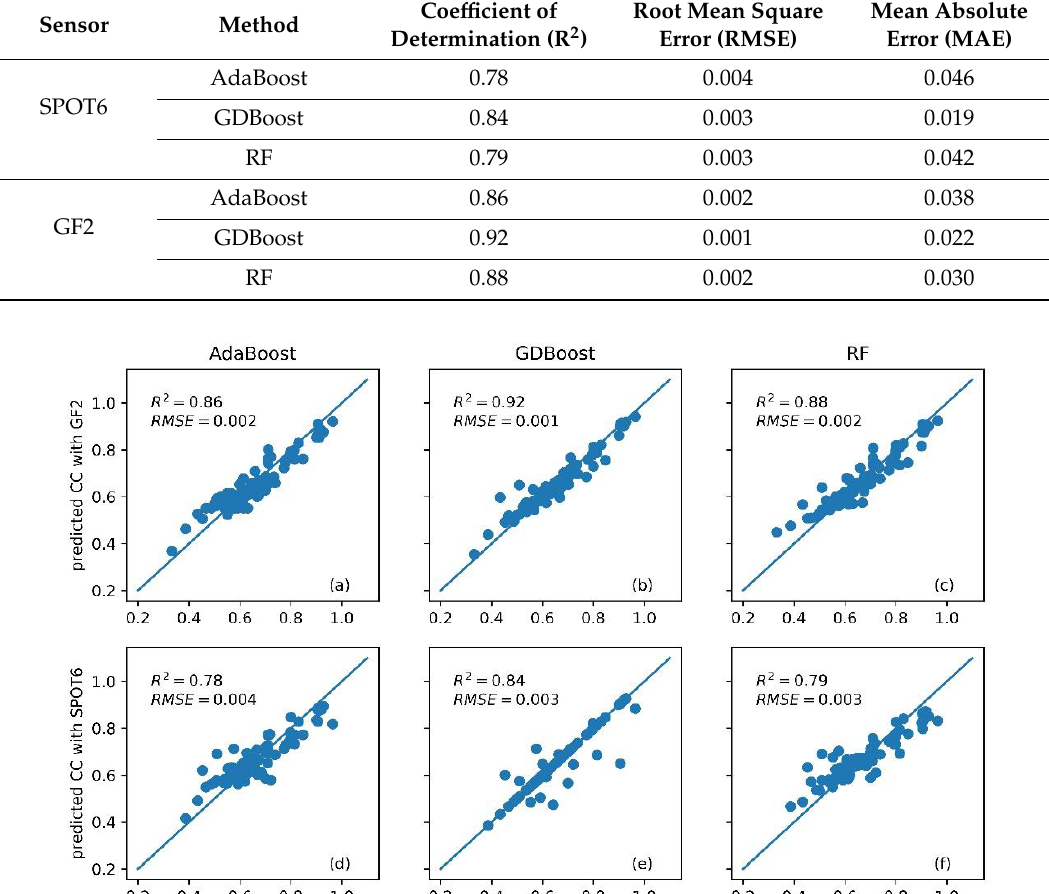
Table 5. Evaluation performance of di ff erent methods in predicting canopy cover.